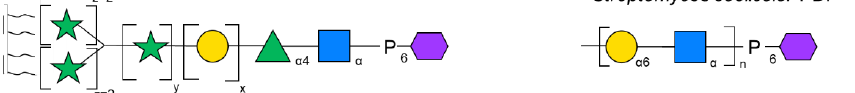
Int. J. Mol. Sci. 2021 , 21 , x FOR PEER REVIEW Figure 1. CWGP substrates of LCP proteins. Repeat-unit structures and the (proposed) linkage to PGN are shown, where investigated. Monosaccharide symbols are shown according to the Symbol Nomenclature for Glycans (SNFG)